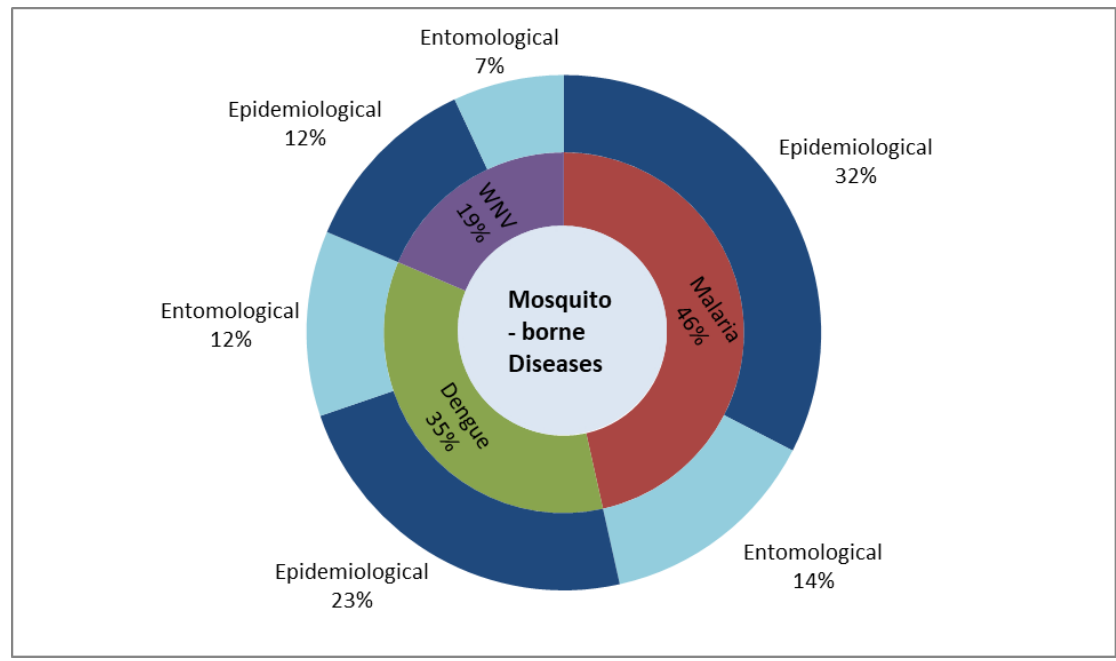
Figure 3. Share of the selected papers as per epidemiological/entomological data and